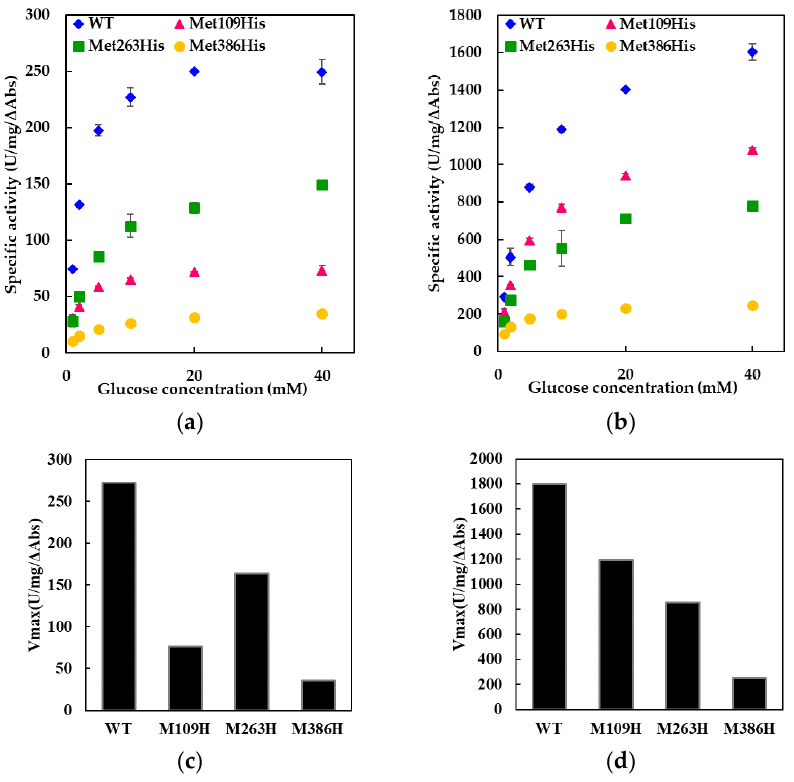
Figure 2. The dye-mediated dehydrogenase activities of WT and mutant FADGDHs. The activities were measured using either ( a ) 2-hexaammineruthenium(III) chloride (Ru-MTT) or ( b ) PMS (PMS-DCPIP) as an electron acceptor. Figure 2c,d are the comparison of Vmax values for WT and mutant FADGDHs using either ( c ) 2-hexaammineruthenium(III) chloride (Ru-MTT) or ( d ) PMS (PMS-DCPIP) as an electron acceptor.